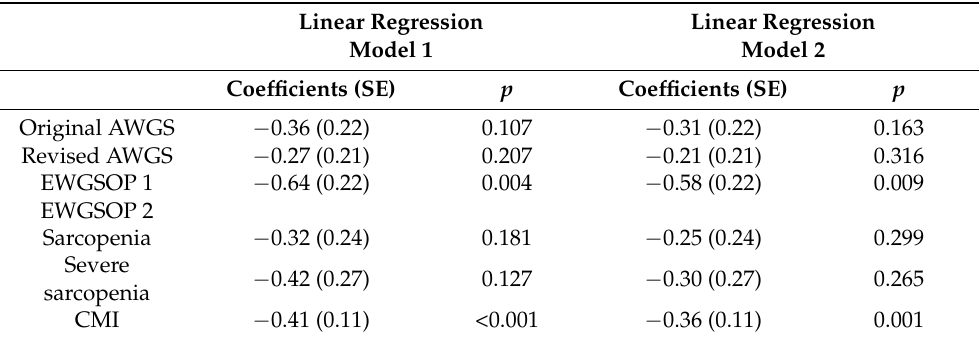
Table 2. Longitudinal associations of sarcopenia with cognitive function measured by the